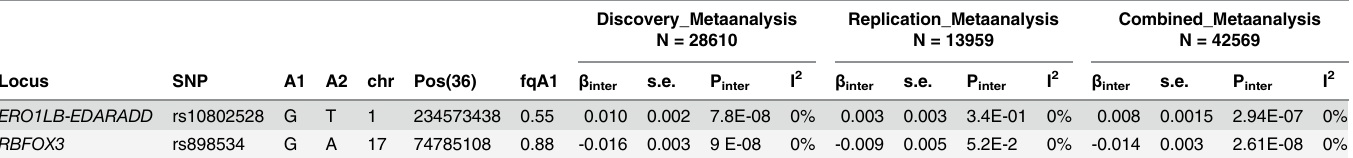
Table 3. Most significant BMI x SNP interaction terms for urate GWAMA.